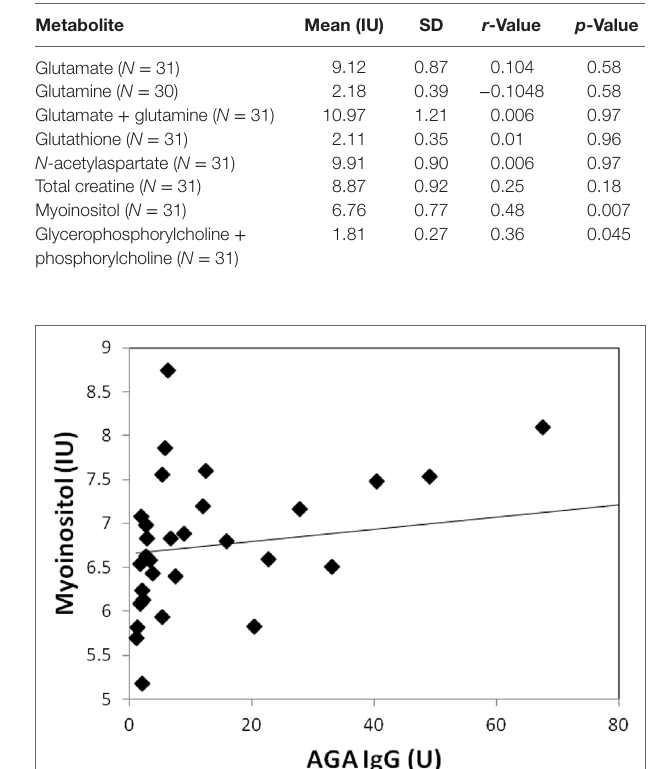
Table 2 | Spearman’s correlations between magnetic resonance spectroscopy measures and AGA IgG in schizophrenia patients.